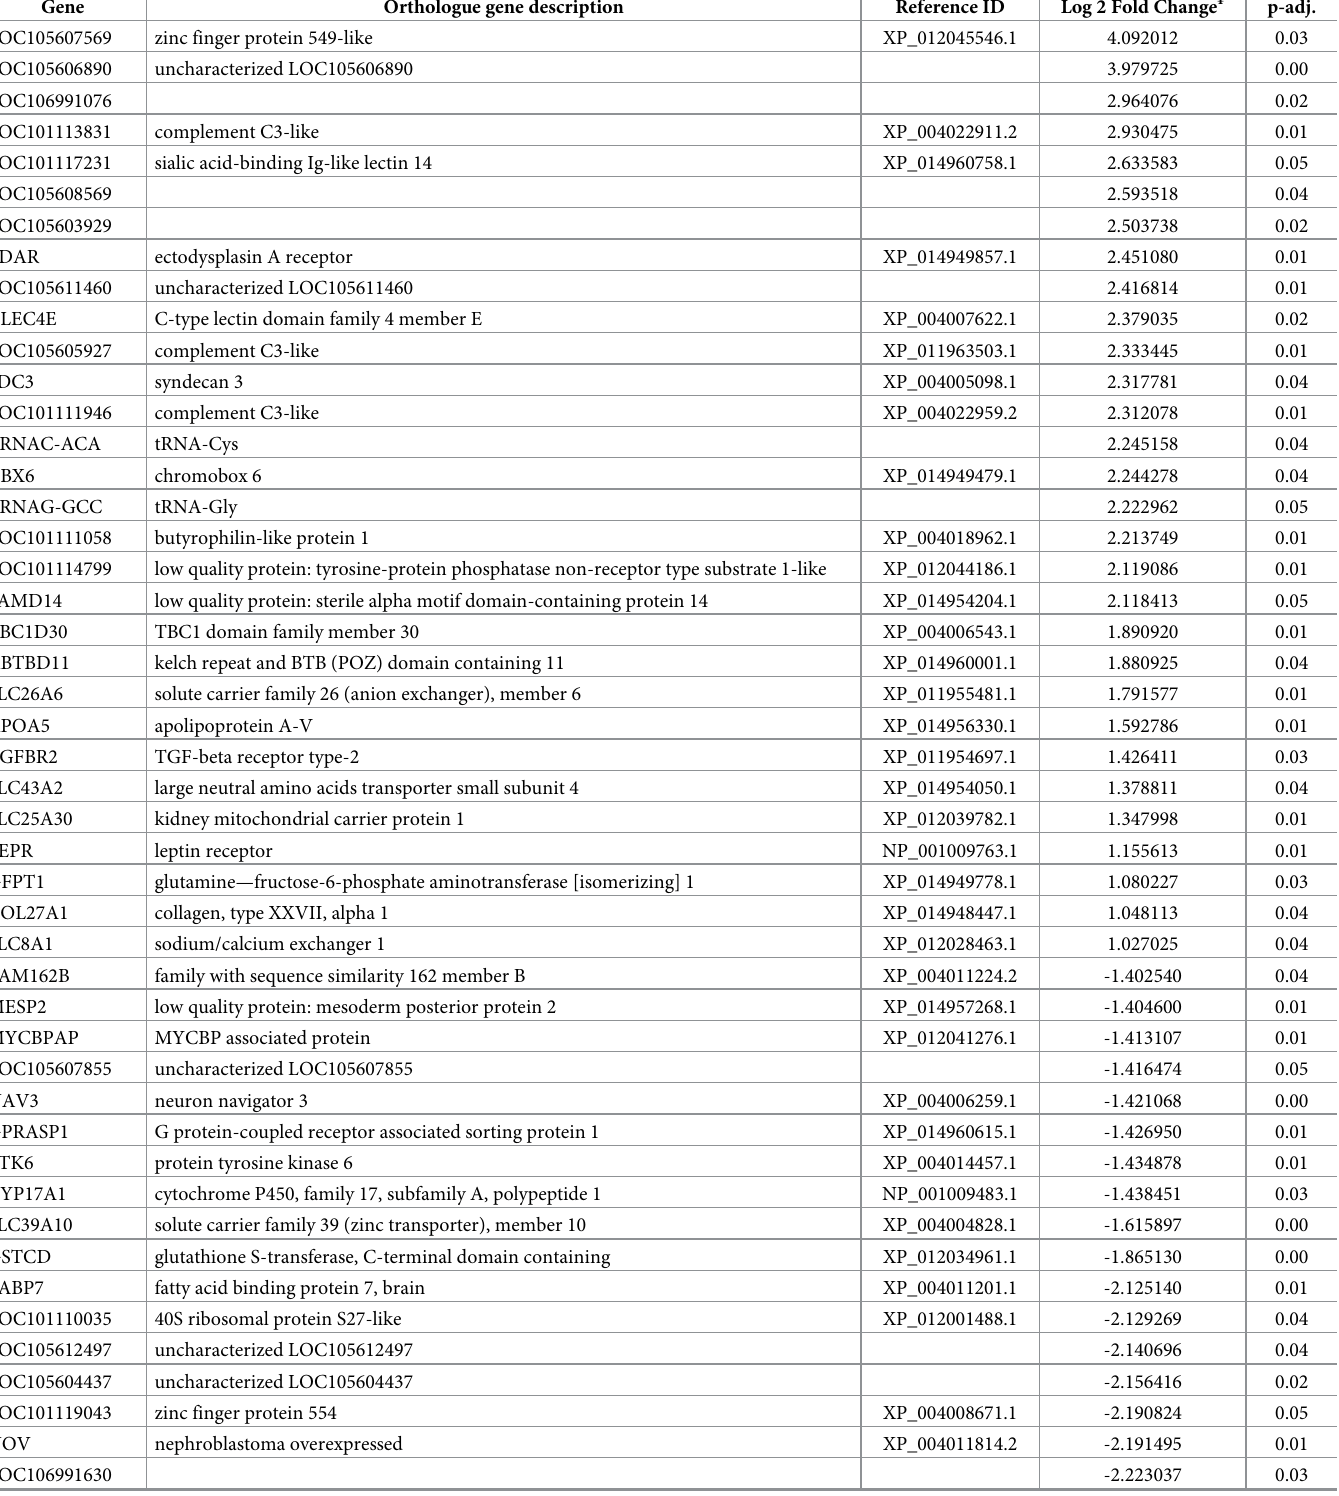
Table 3. Top 30 up- and down-regulated genes in liver tissues collected from sheep with higher and lower unsaturated fatty acids.